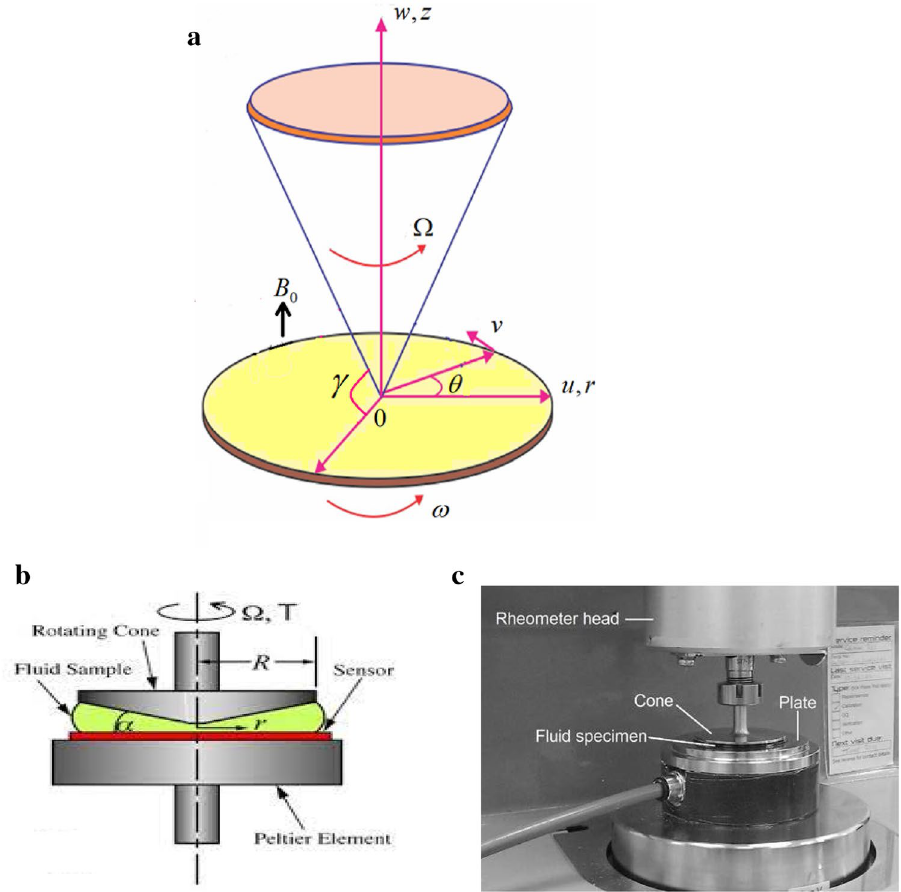
Figure 1. ( a ) Physical flow configuration. ( b ) Graphical model of a cone-plate rheometer 44,45 . ( c ) Actual model of a cone-plate rheometer 44,45